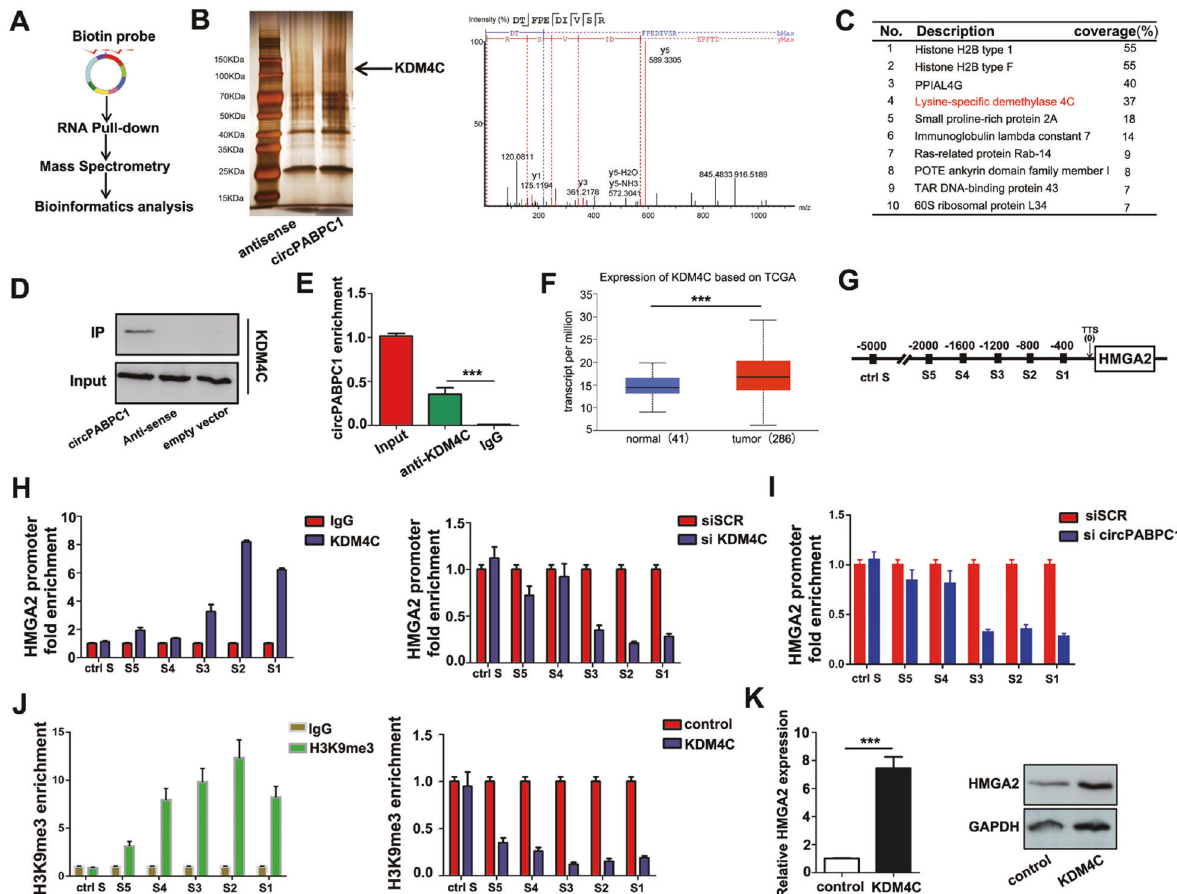
Fig. 4 CircPABPC1 interacts with KDM4C and regulates H3K9me3 modi fi cation on the HMGA2 promoter. A Schematic illustration showing the details of circPABPC1 RNA pull-down and mass spectrometry. B Silver staining was used to illustrate the circPABPC1-precipitated proteins. C The top 10 precipitated proteins with high scores are shown. D The mass spectrometry results were further validated by western blotting. E The interaction of circPABPC1 and KDM4C was con fi rmed by RIP assay. F The expression of KDM4C in CRC patients was explored by TCGA database. G , H The enrichment of KDM4C on the promoter of HMGA2 was detected by ChIP assay. IgG was used as negative control. I The enrichment of KDM4C on the promoter of HMGA2 was detected by ChIP assay after circPABPC1 knockdown. J The enrichment of H3K9me3 modi fi cation on the HMGA2 promoter was detected by ChIP assay. IgG was used as negative control. K The effect of KDM4C on HMGA2 expression was measured by western blot analysis. Quantitative data from three independent experiments are shown as the mean ± SD (error bars). * P < 0.05, ** P < 0.01, *** P < 0.001 (Student ’ s t test). Taken together, these results suggested that circPABPC1 functions as a sponge of both miR-874 and miR-1292. ADAM19 and BMP4 are upregulated in CRC and are regulated by circPABPC1 RNA fold software prediction allowed visualization of the mature and stable secondary structures of both miR-874 and miR-1292 (Fig. 6A). Through overlapping the results of miRNA target prediction by miRWalk, miRDB, TargetScan and our RNA-seq data, ADAM19 was identi fi ed as a putative target of miR-874, and BMP4 was identi fi ed as a putative target of miR-1292 (Fig. 6B, Fig. S7A). Through TCGA database analysis, we found that BMP4 expression was signi fi cantly higher in CRC tissues than in normal tissues and other types of tumors (Fig. S7B, C). The expression of ADAM19 was also aberrantly higher in CRC and associated with nodal metastasis (Fig. S7D, E). We also con fi rmed the expression of ADAM19 and BMP4 in CRC patients by qRT – PCR analysis (Fig. 6C). The mRNA levels of ADAM19 and BMP4 were signi fi cantly inhibited after miR- 874/miR-1292 overexpression (Fig. 6D), while circPABPC1 cotrans- fection reversed this inhibition (Fig. 6E), indicating that circPABPC1 sponges miR-874/miR-1292 and modulates ADAM19 and BMP4 expression. In addition, biotin RNA pull-down also